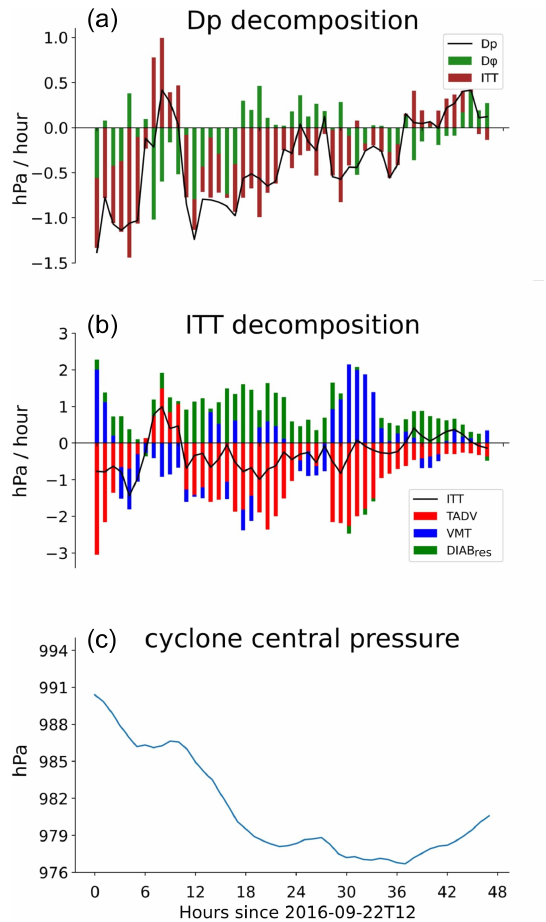
Figure 11. Time series of the PTE analysis during the cyclone de- velopment from 22 September 2016 at 12:00 for the 2.5km EC sim- ulation with one-moment cloud microphysics. The PTE terms are averaged over a 3 ◦ × 3 ◦ latitude–longitude box centered around the cyclone location. (a) Surface pressure tendency and its decomposi- tion. (b) Decomposition of the ITT term. (c) Central pressure of the